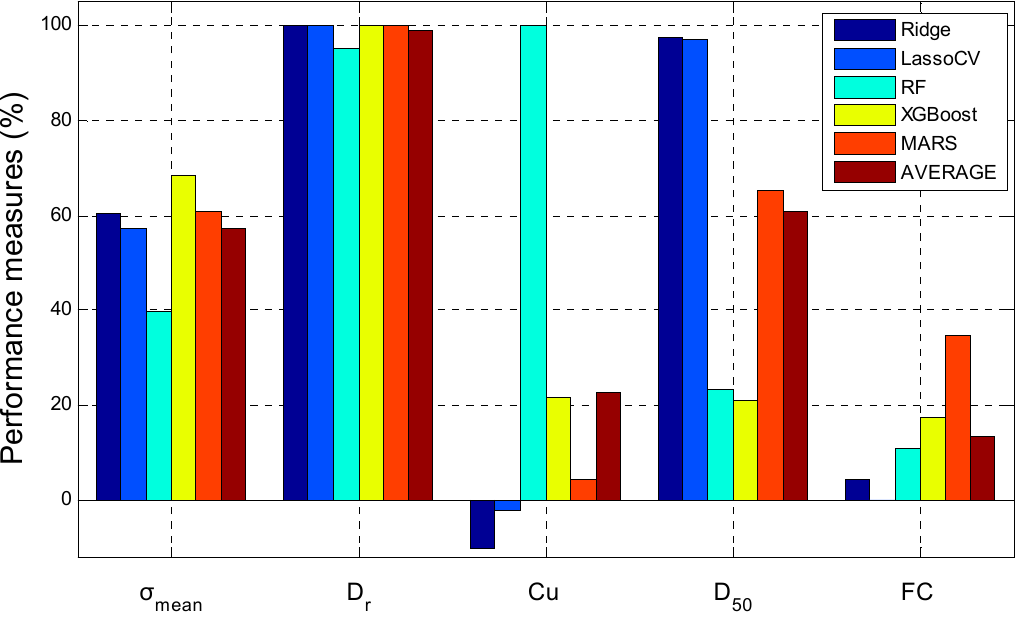
Figure 35. Comparison of the relative importance of the input variables.